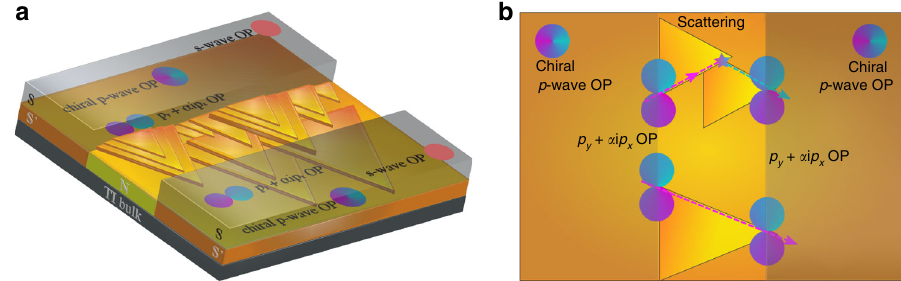
Fig. 6 Sketch of the device showing the induced order parameter and the occurrence of π -paths across the junction. a Three-dimensional sketch of the Bi 2 Te 3 device. The Al electrodes (S) induce an effective p + s -wave superconductivity on the surface of the TI. In the picture we consider only the chiral term of the total OP. In close proximity of a low transparency interface the chiral p x + i p y changes symmetry resulting in a predominant p y component (see main text for details). b Top view of the device. The occurrence of scattering at the pyramid corners and/or at the merging points of two pyramidal domains, in the N region of the junction, makes quasiparticle trajectories emerging from a negative p y lobe (blue arrow) on one side of the junction to couple with trajectories that probe the negative p y lobe (red arrow) on the other side of the junction. In case of scattering-free transport in the N region the quasi-particles trajectories probe the same phase in both electrodes (red arrows)